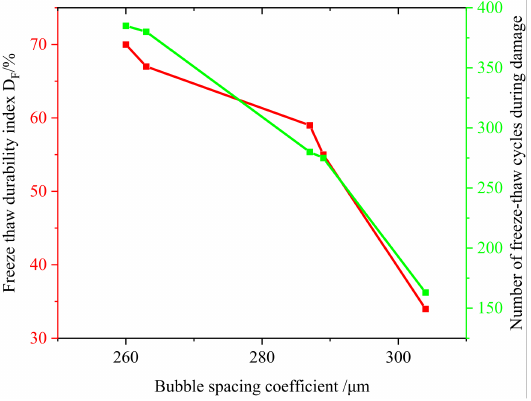
Figure 28. Effect of bubble spacing coefficient on concrete frost